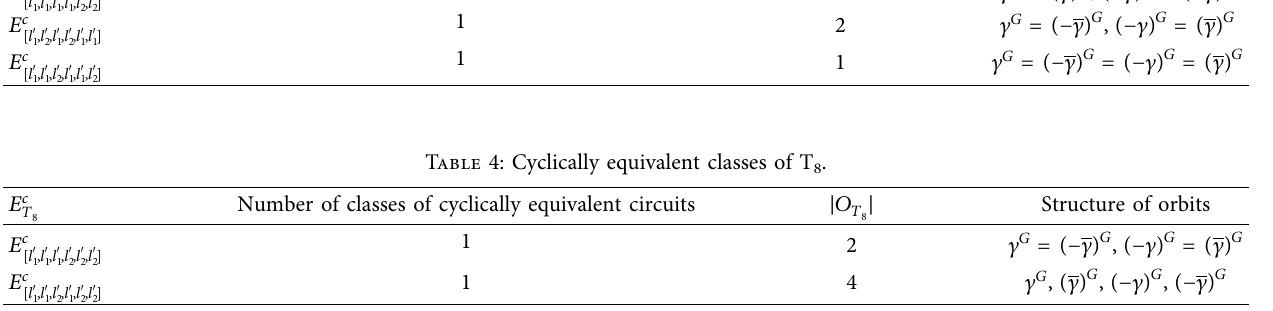
Table 3: Cyclically equivalent classes of T